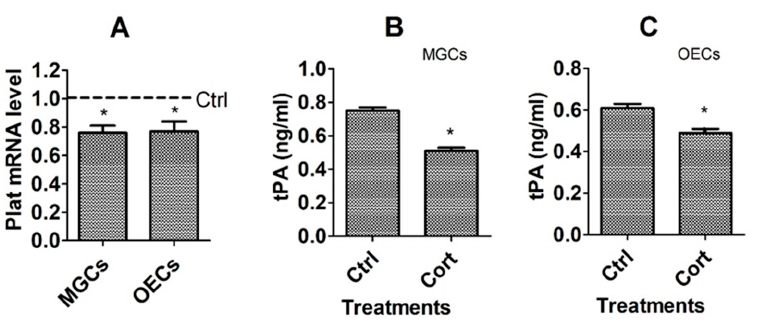
Figure 3. Effects of corticosterone treatment on mRNA and protein levels of tPA in MGCs and OECs. Graph ( A ) shows mRNA level of the Plat gene revealed by RT-qPCR. Each treatment was repeated 3 times with each replicate, including cells from 2 wells of a 6-well plate from 12 mice (MGCs) or 2 wells of a 12-well plate from 4 mice (OECs). The mRNA level in control (Ctrl) cells was set to one (dotted line) and the level in corticosterone-treated cells was expressed relative to it. Graphs ( B , C ) show levels of tPA protein in CM conditioned for 24 h by MGCs and OECs, respectively, in the presence of corticosterone, as revealed by ELISA. Each treatment was repeated 3 times, with each replicate including CM from 2 wells of a 6-well plate from 12 mice (MGCs), or 2 wells of a 12-well plate from 4 mice (OECs). * Indicates significant difference ( p < 0.05) from Ctrl cells.